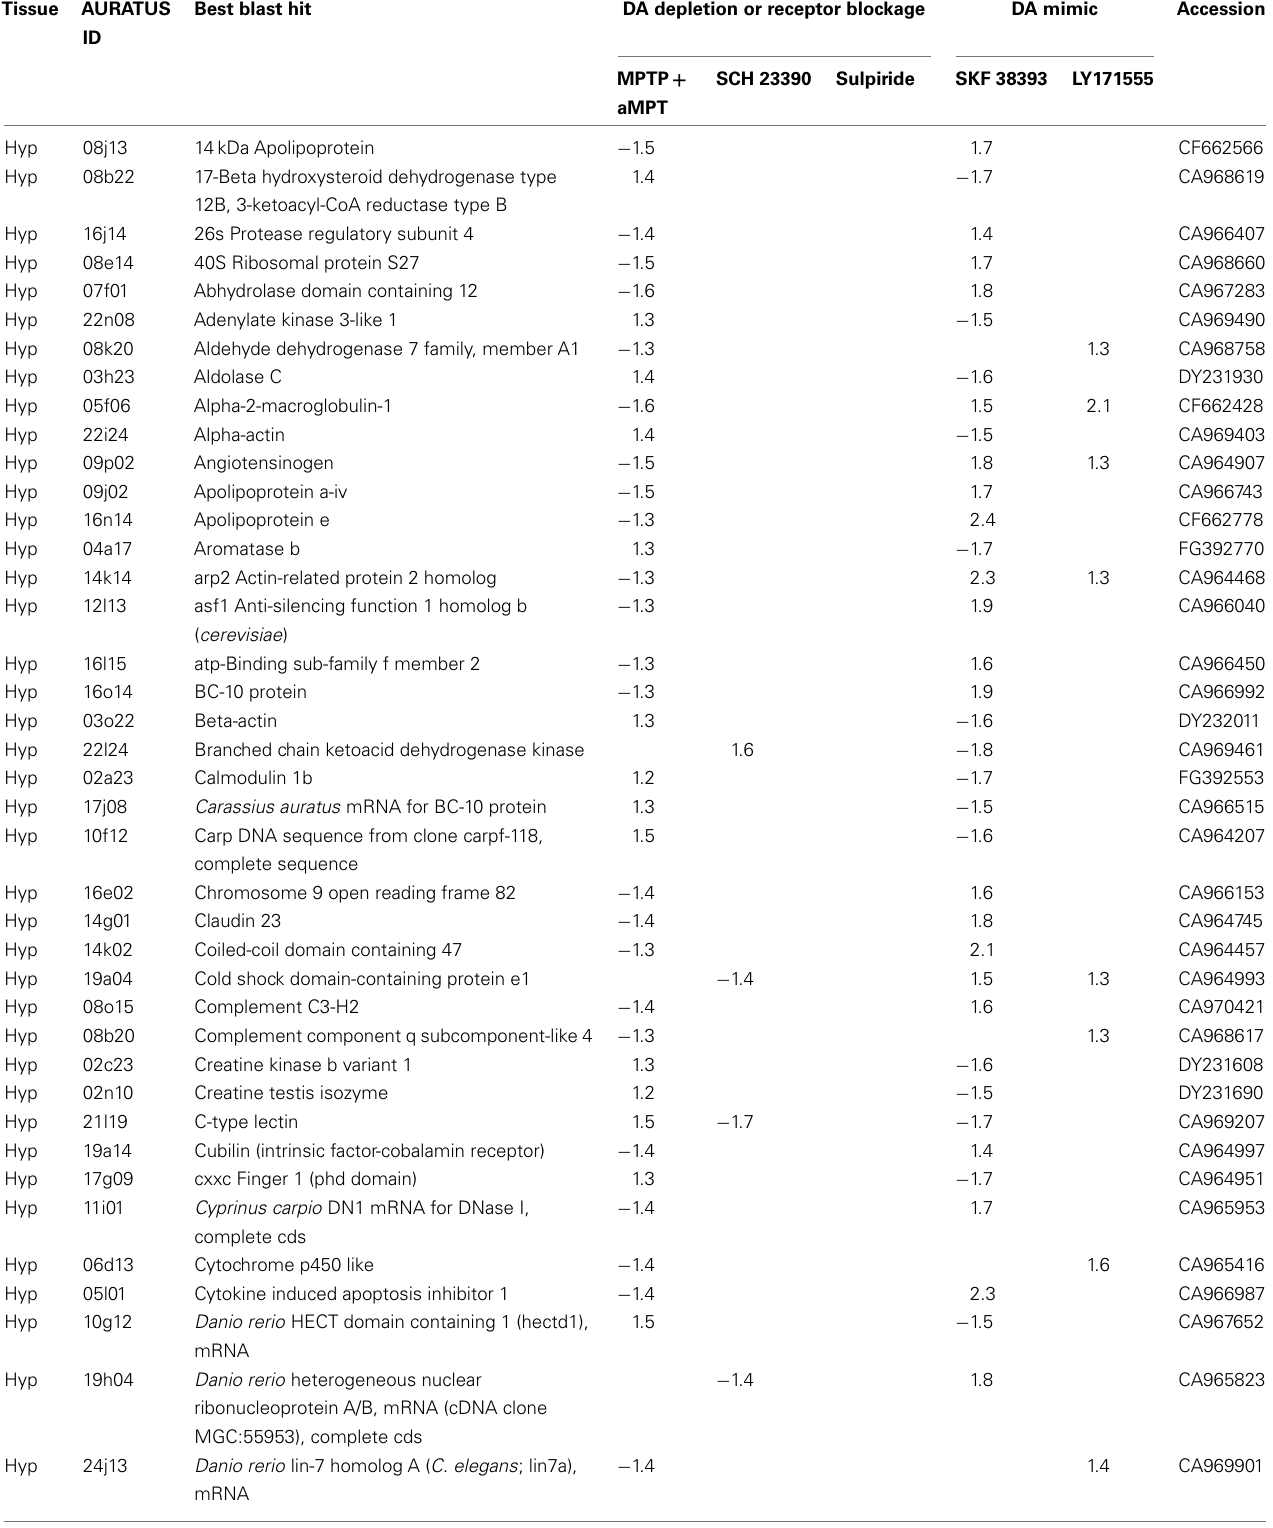
TableA1 | ESTs were manually selected based on identicalAURATUS GeneIDs and on the basis of differential regulation in opposite directions for MPTP or the antagonists vs. agonists, or in the same direction for MPTP vs. antagonists. Tissue